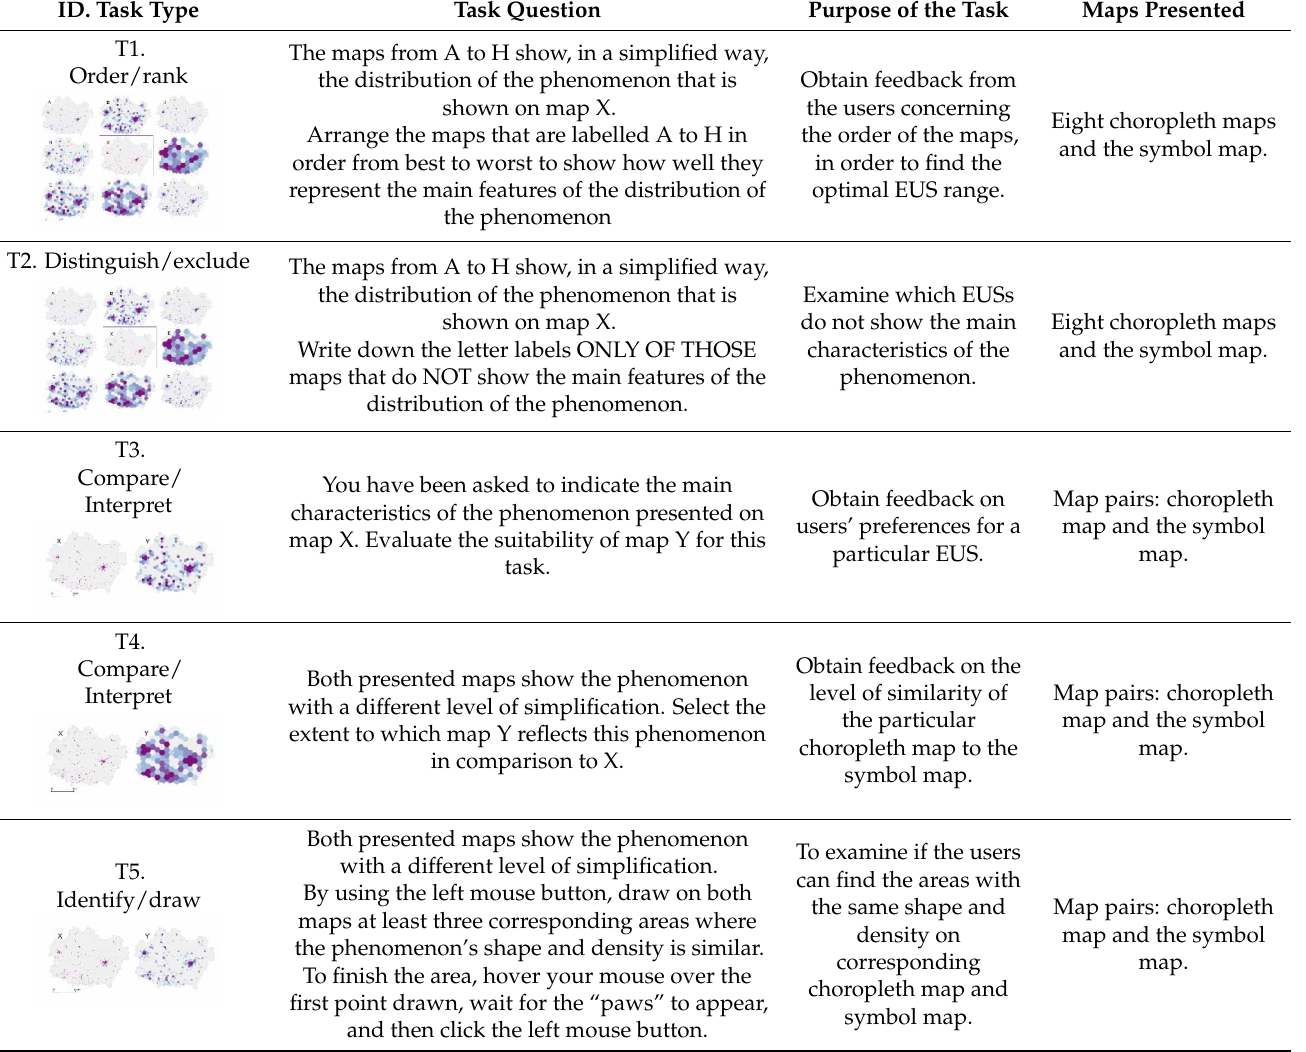
Table 1. Tasks that were tested in the study. The maps used in this table are presented in Supplementary Materials (Figure S1). ID. Task Type Task